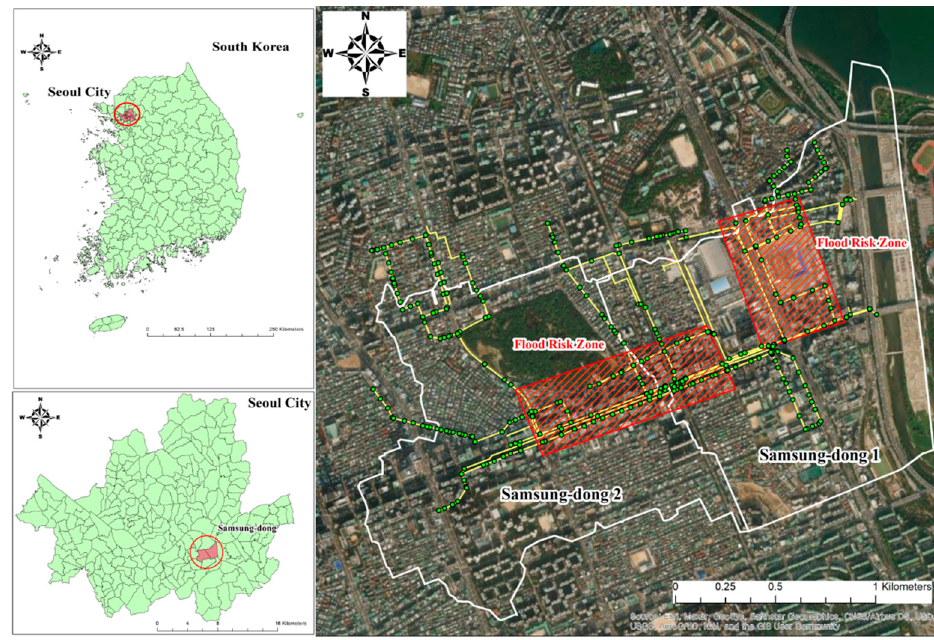
Figure 1. Location of the study area in the Samsung-dong and flood risk zone.